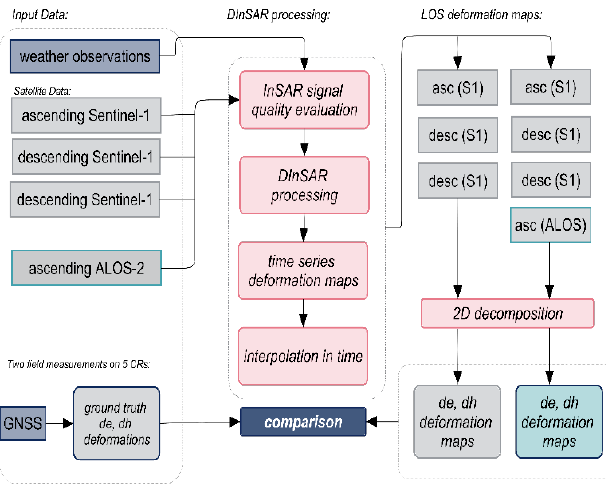
Figure 2. The overall methodology of the presented study